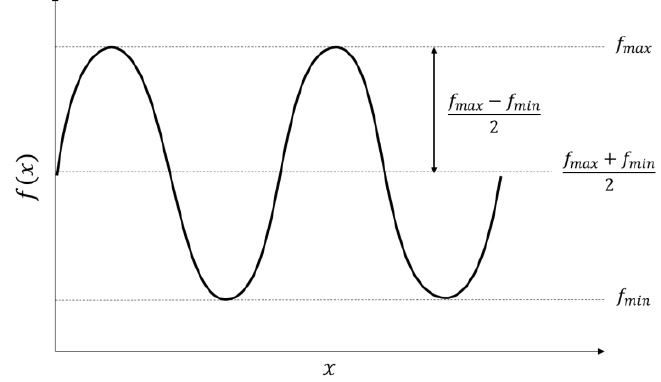
Figure 2. Example of periodic signals with a constant amplitude.